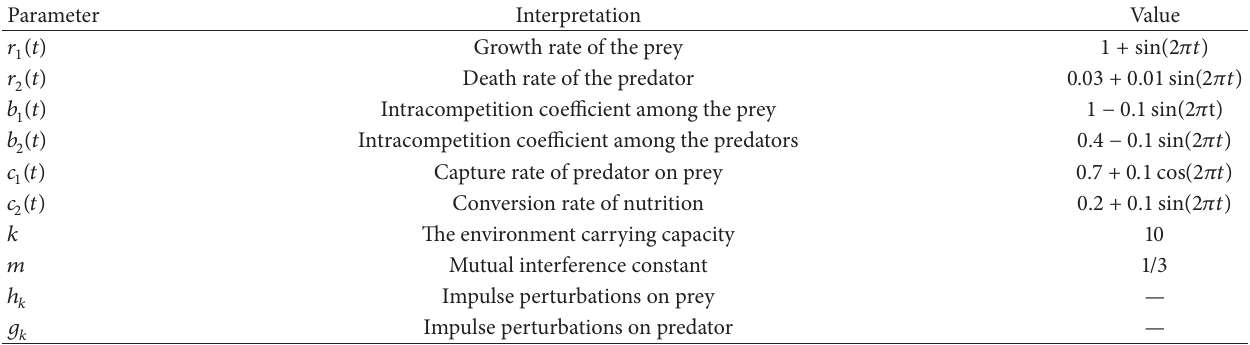
Table 1: Parameter values used in the simulations of system